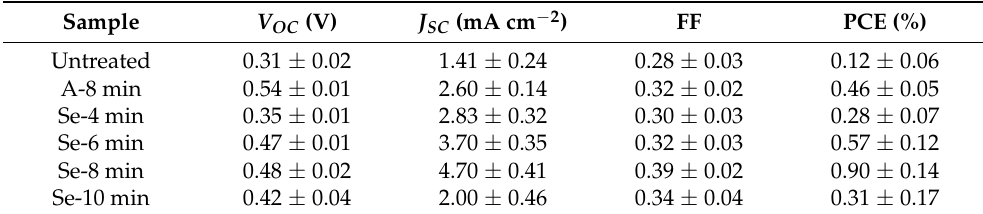
Figure 3. Performance test of the devices based on CuSbS 2 and CuSbS 2 (Se): ( a ) the structure of CuSbS 2 (Se) solar cells; ( b ) J–V characteristics under illumination, ( c ) EQE, ( d ) J–V characteristics in dark of CuSbS 2 device and CuSbS 2 (Se) devices selenized for different durations; ( e ) shunt conductance G characterizations, ( f ) ideality factor A and reverse saturation current density J 0 characterizations. Table 1. The detailed photovoltaic parameters of CuSbS 2 and CuSbS 2 (Se) solar cells selenized for varied